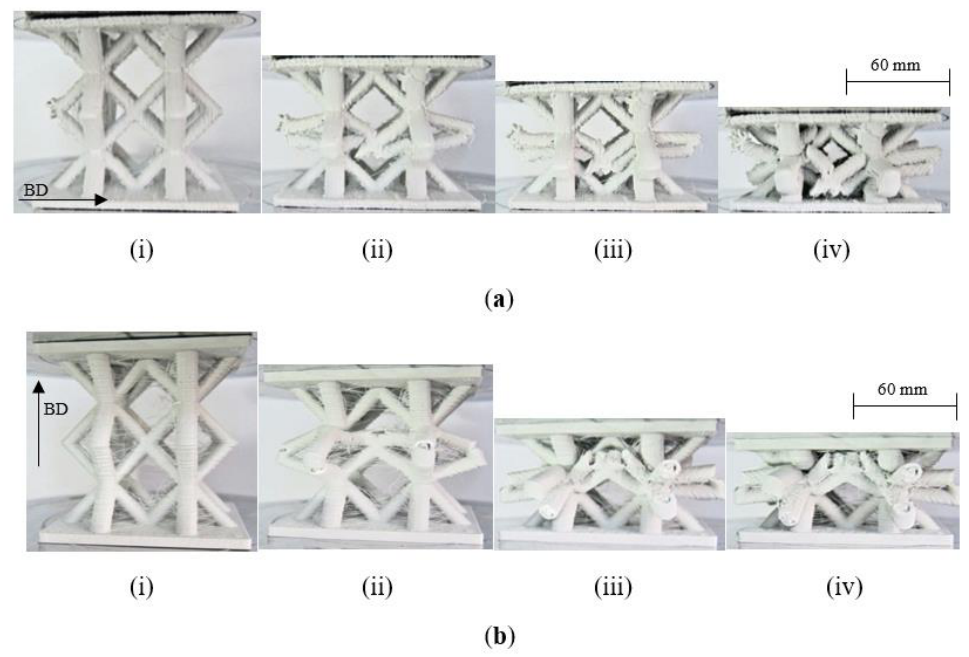
Figure 10. Photographs showing the effect of build direction on failure mechanisms in a lattice structure. The build direction is indicated by the arrow. ( a ) Lattice structure (n = 1) manufactured in the horizontal direction and ( b ) lattice structure (n = 1) manufactured in the vertical direction.